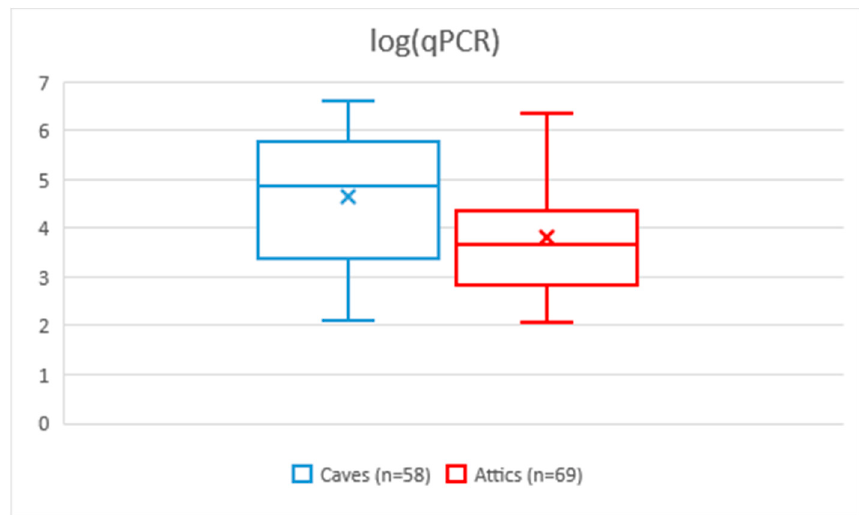
Figure 3. Box plot with qPCR values on a logarithmic scale. Figure interpretation. × corresponds to the geometric mean, the rectangle indicates the area between the upper and lower quartiles, and the horizontal line indicates the median and the vertical lines the range of values.